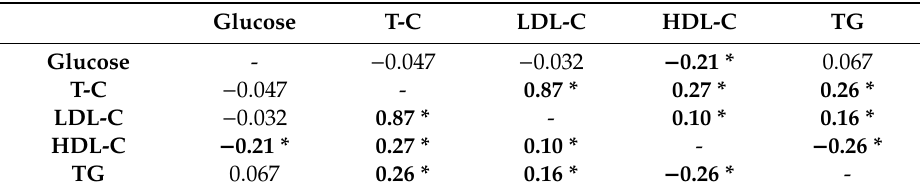
Table 12. Correlations by Spearman’s